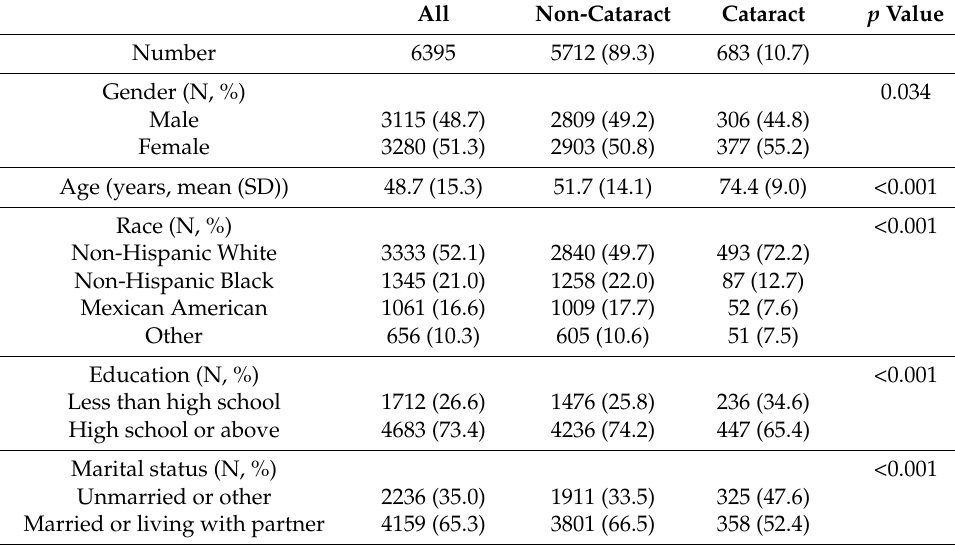
Table 1. Characteristics of participants stratified by cataract from NHANES 2005–2008.